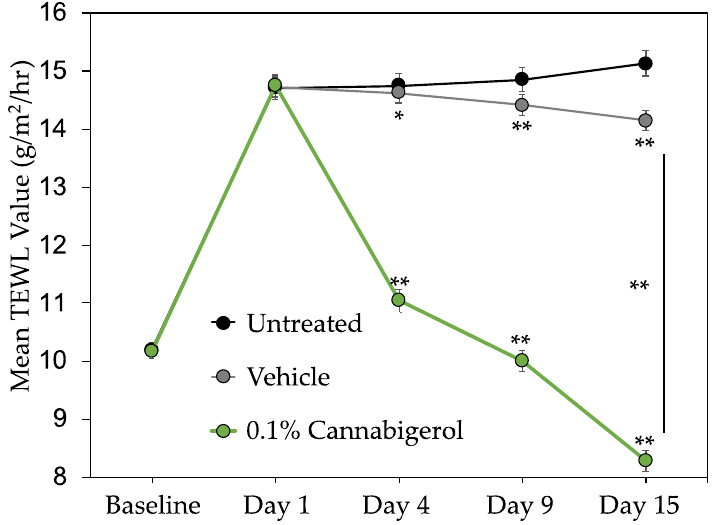
Figure 3. Clinical study utilizing 0.1% CBG in serum formulation shows improvement in hydration levels over untreated and vehicle-treated skin. Transepidermal water loss (TEWL) was measured with a Tewameter ® TM300 instrument with lower readings demonstrating an increase in hydration and skin barrier function. Data ( n = 20) represent mean ± SEM. * p < 0.05; ** p ≤ 0.01 indicates a statistically significant difference compared to baseline reading. Table 3. Grading scale for skin irritation in clinical study.